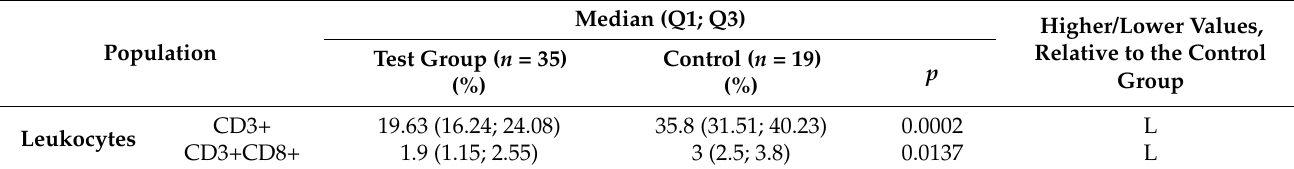
Table 3. Differences between study groups in the percentage of CD3+ and CD3+CD8+ lymphocytes in leukocyte